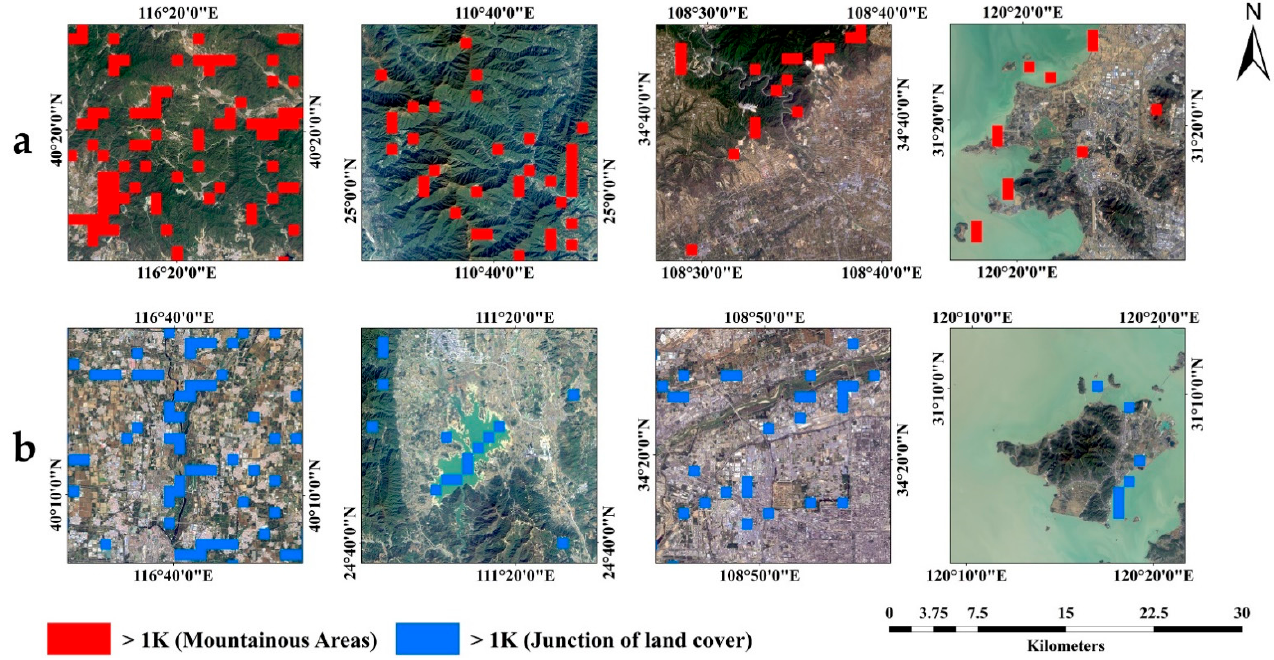
Figure 10. The representative areas with errors greater than 1 K in four study sites were selected from site 1 to site 4 from left to right: ( a ) mountain areas with errors greater than 1 K; ( b ) junction of land cover types with errors greater than 1 K.